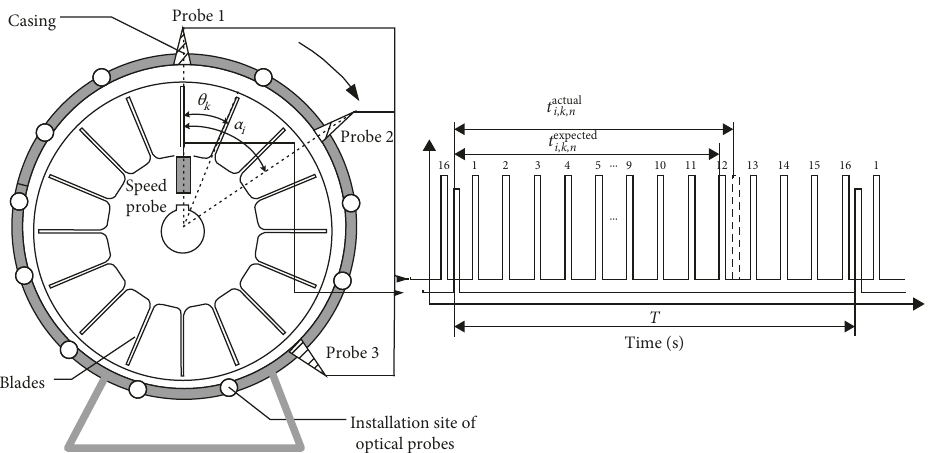
Figure 1: Basic principle of the BTT